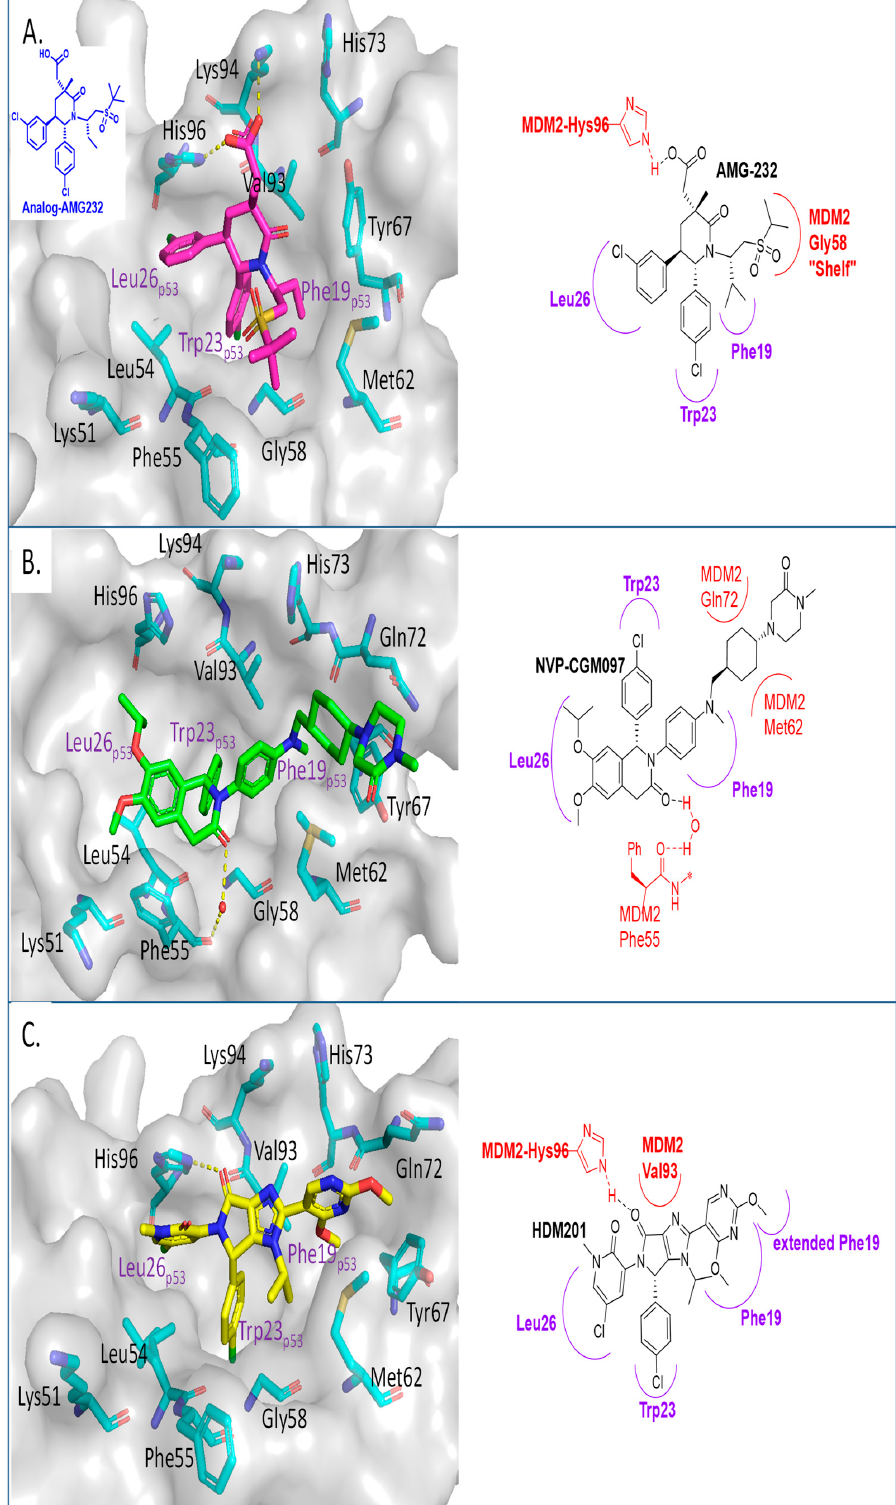
Figure 4. Co-crystal structures and chemical structures of inhibitors bound to the MDM2 protein: ( A ) AMG-232; ( B ) NVP-CGM097; ( C ) and NVP-HDM201. Labels and semicircles in magenta indicate the binding pockets in MDM2 where the p53 residues Phe19, Trp23, and Leu26 bind. Labels in red indicate MDM2